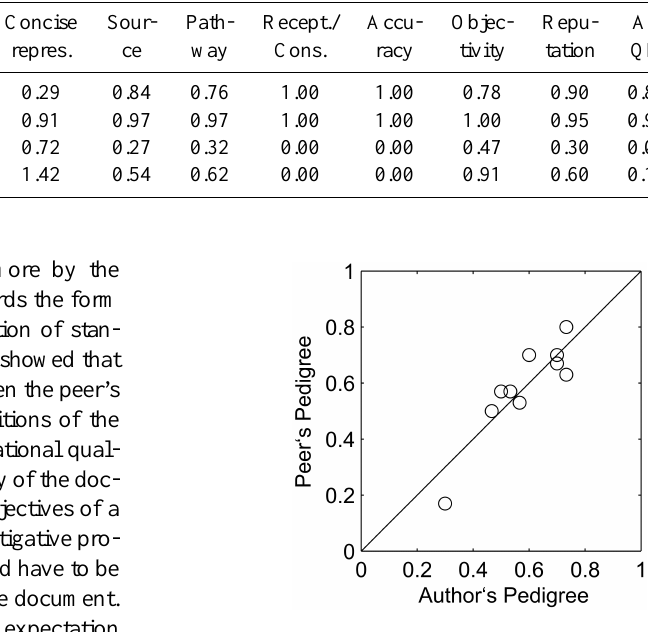
Fig. 2. Comparison of the peer’s P with the authors’ P ( N =